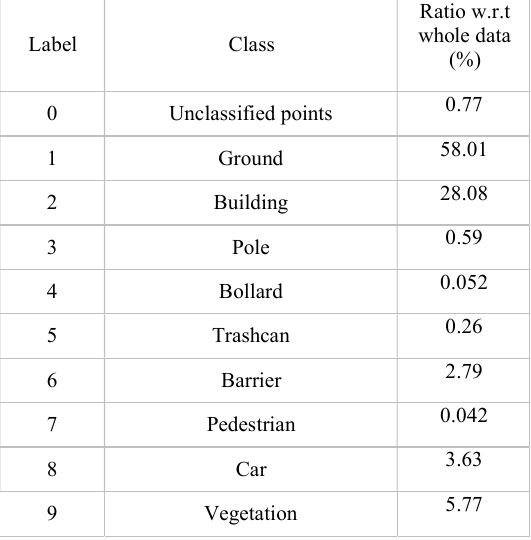
Table 2. The percentage of each class to the